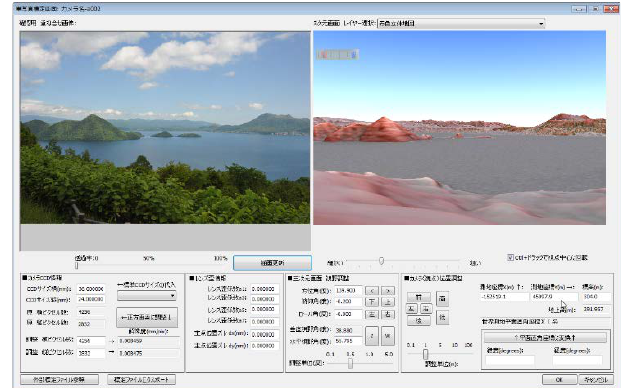
Figure 5. Image orientation